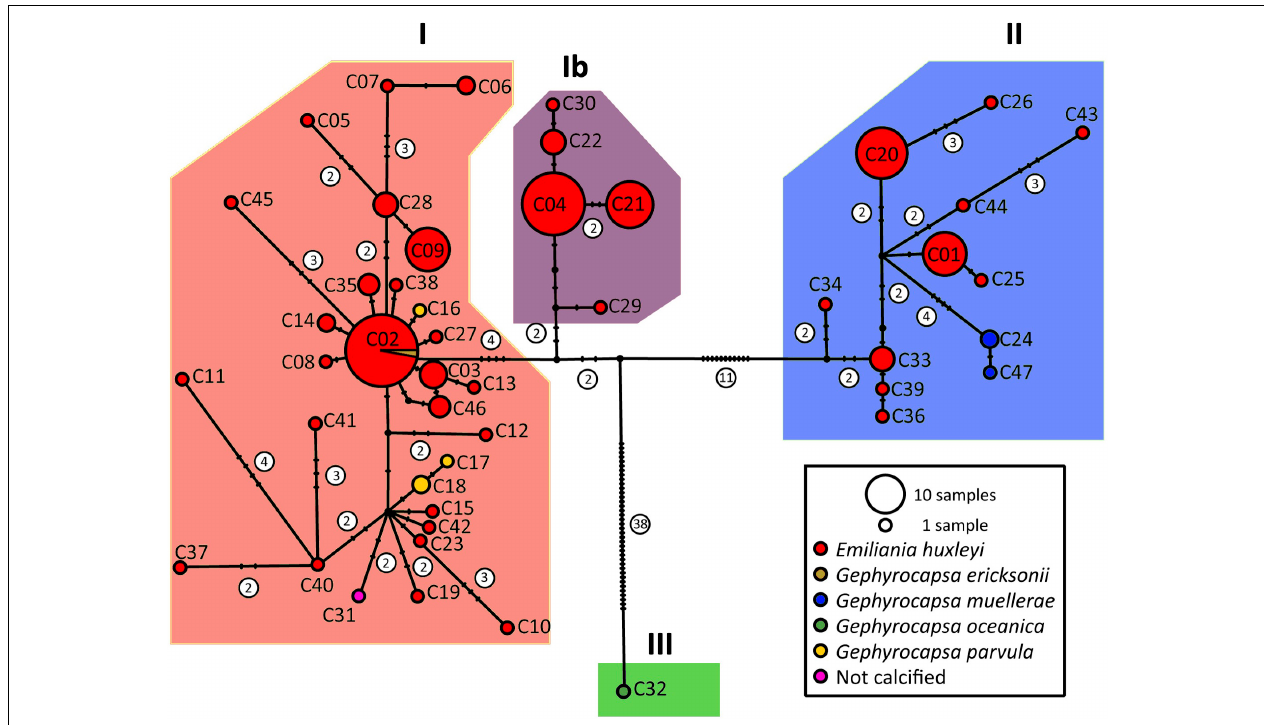
FIGURE 1 | Haplotype network based on concatenated alignment of cox1–cox3 . Diagnostic graphs for the ABGD analysis are in Supplementary Figure 1 . The same network is re-plotted with key strains in Supplementary Figure 2 , haplogroups are given in Supplementary Figure 3 and Supplementary File 1 . The latter file also associates strains and haplotypes. ABGD analysis and haplotype networks for cox1 and cox3 separately are in Supplementary Figures 4–9